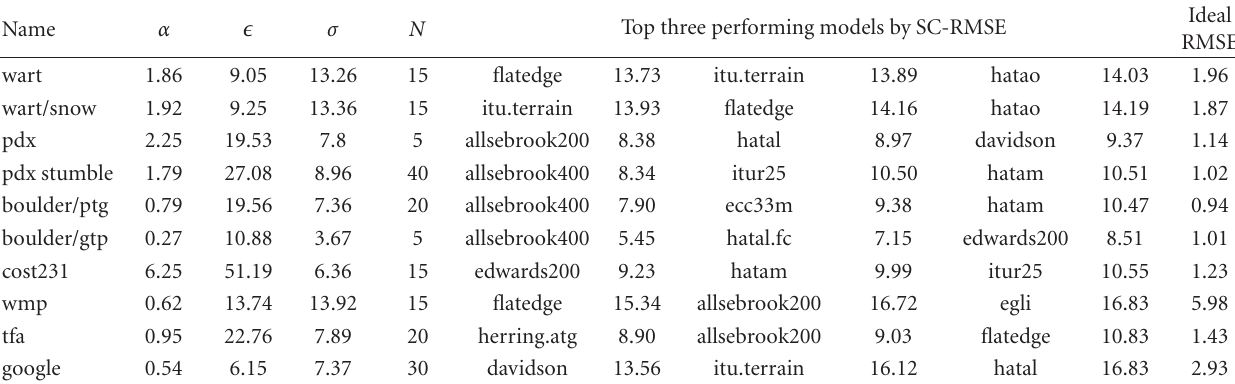
Table 3: Summary of results by data set.